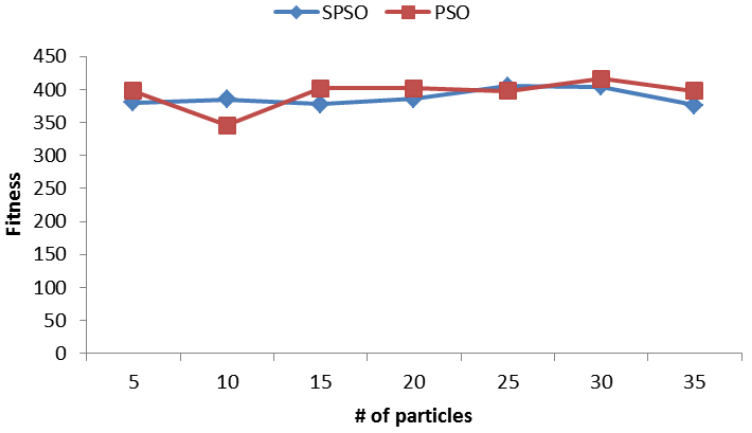
= 2, c = 2, V = 3). 1 2 max